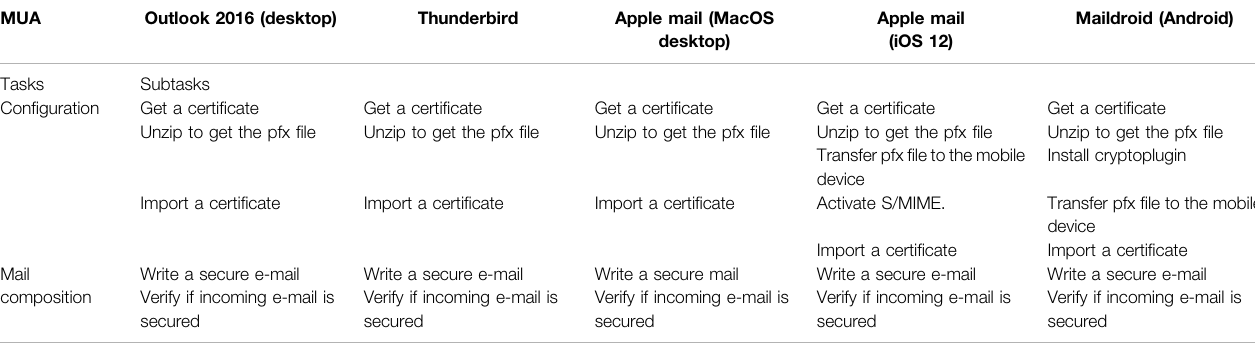
TABLE 7 | Analysis of S/MIME tasks with fi ve MUAs.